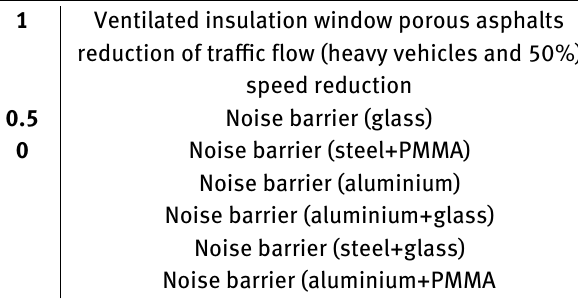
Figure 11: Results for the two